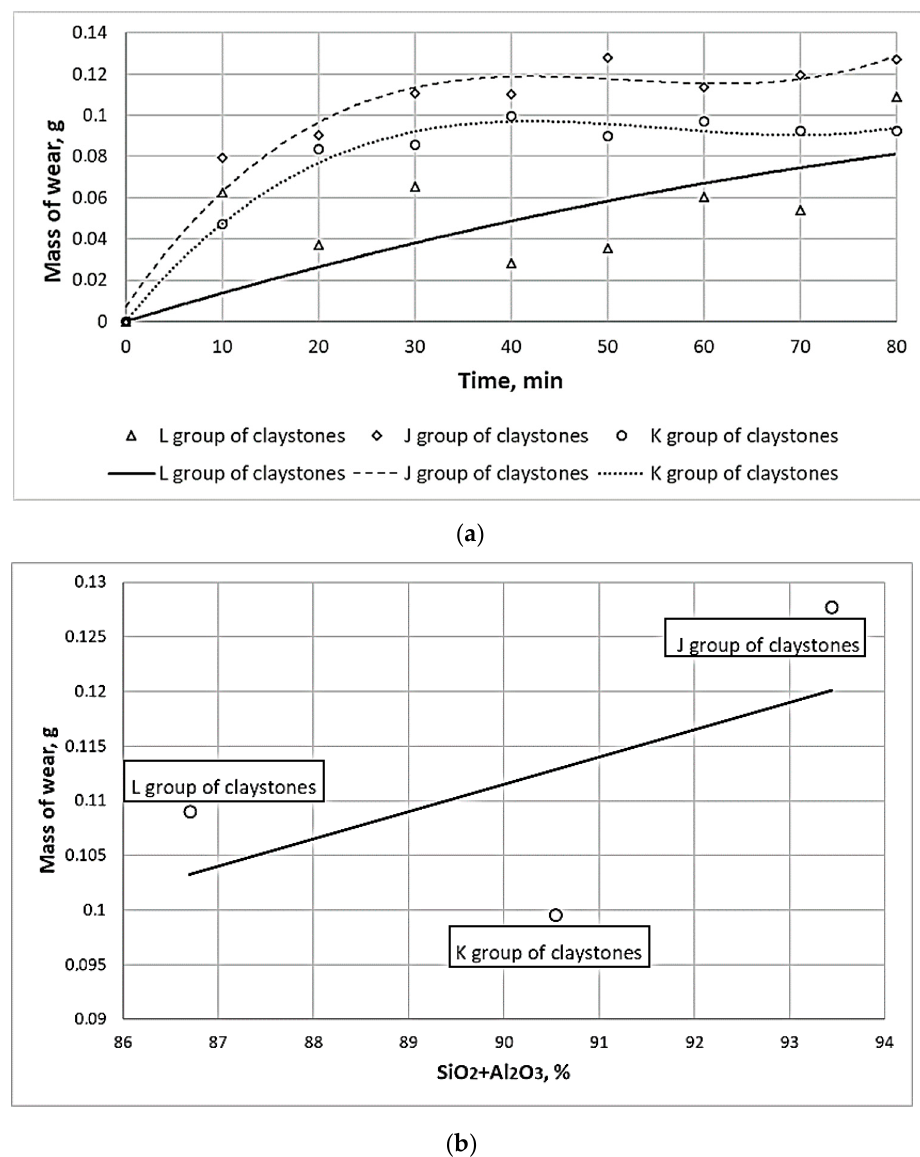
Figure 6. Wear diagram at maximum load ( a ) as a time curve; ( b ) in a function of chemical content.